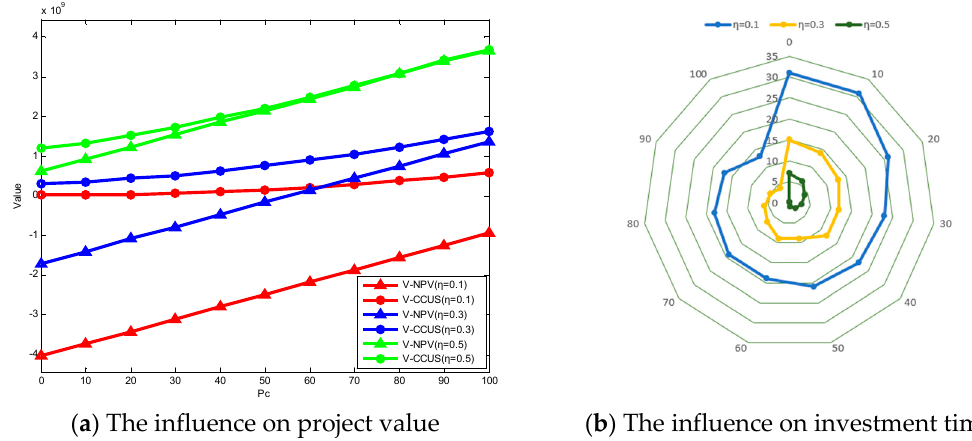
Figure 6. The impact of the carbon utilization rate on the NPV and investment value of CCUS.